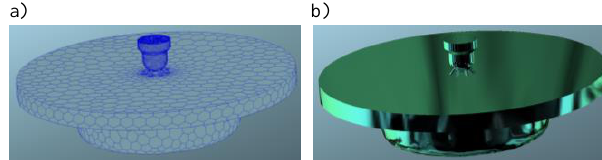
Fig. 5. The adopted initial dose values for prechamber and the correspond- ing values of the air excess coefficient during ignition Gas injection at high doses in the early phase of the pis- ton movement was found to cause the flow of this mixture to the main chamber (Fig. 6 – 2.5 mg). During the compression stroke, this tendency is not observed only at the smallest values of the dose fed into the cylinder. In the vicinity of the ignition angle in prechamber there is still no homogeneous combustible mixture. However, with q values in the range o